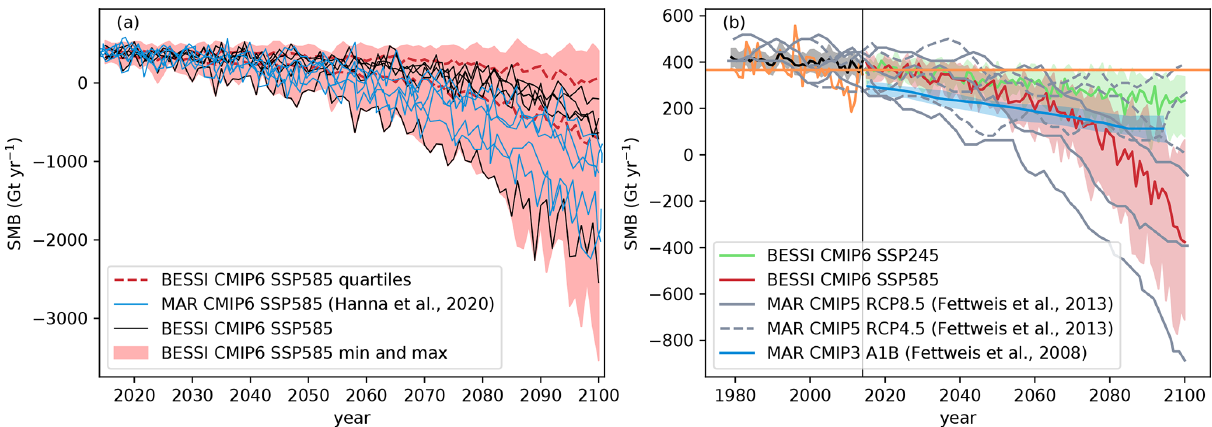
Figure 9. (a) SMB simulated by the regional climate model MAR (blue; Hanna et al., 2020, their Fig. 11) and the mean of our simulations (black), forced by the same CMIP6 models, scenario SSP585. The red shading illustrates the minimum and the maximum of SMB for our entire ensemble for this scenario, and the dashed lines are 25% and 75% percentiles. (b) Comparison of our simulations with BESSI, Fettweis et al. (2013), their Fig. 4a, and Fettweis et al. (2008), their Fig. 7a. Fettweis et al. (2013) use three different ESMs as input, and thus there are three grey lines for every scenario. The shading are 25% and 75%